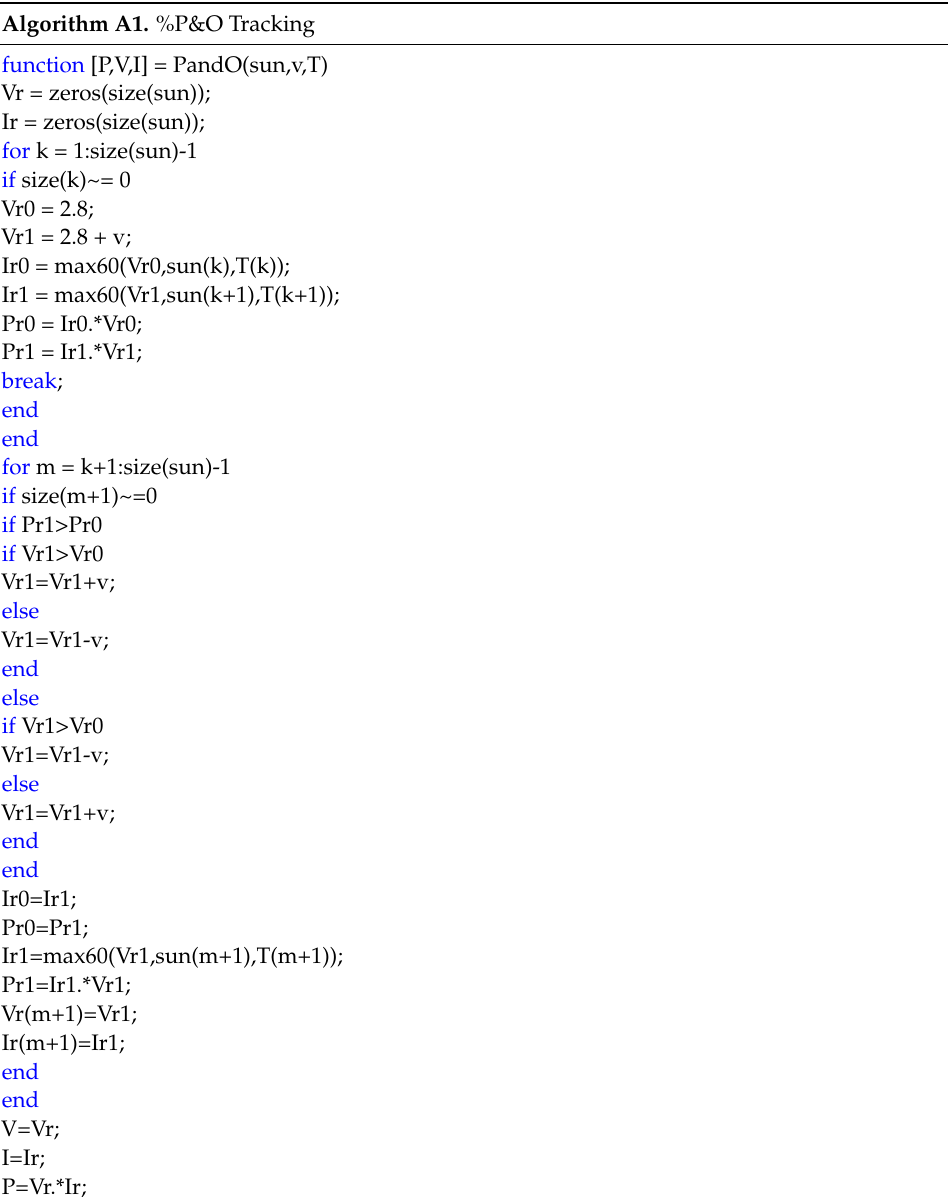
Algorithm A1. %P&O